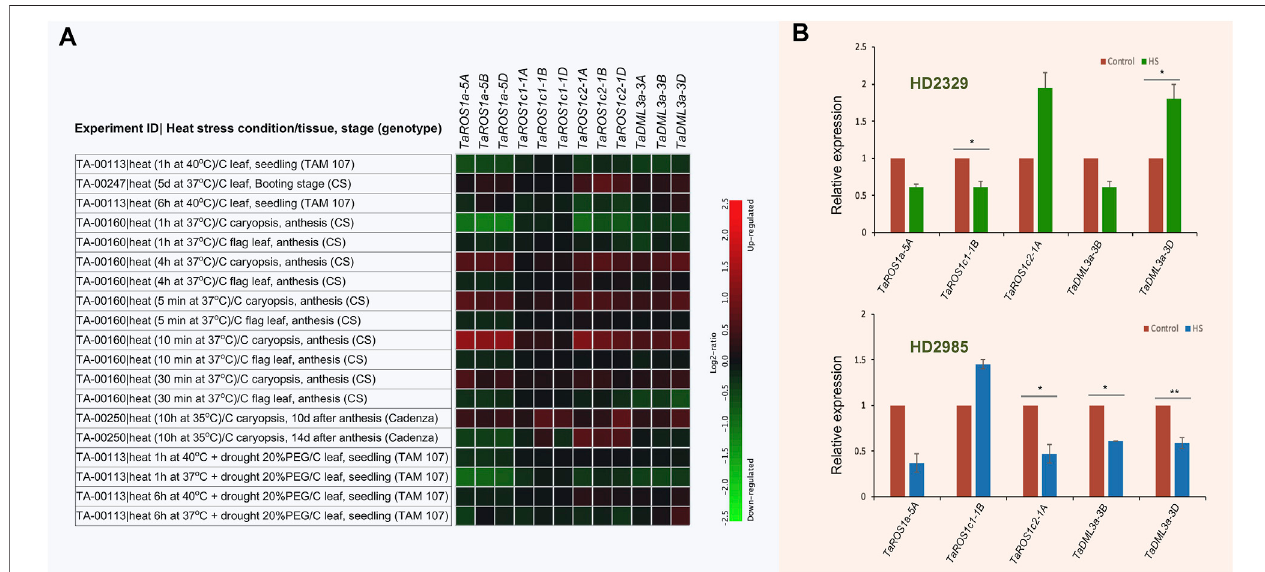
FIGURE7| Expressionpro fi lesofwheat dMTase genesunderheatstress(HS) conditions. (A) Heatmap showingtheexpression of12 TadMTase genesinvarious tissuesanddevelopmentalstagesduringheatstressconditions.The “ heatmap ” colorrepresents relativeexpression values,calculatedaslog2ratiosbetweenthesignal intensities from HS treated genotypes vs. controls (C). The red color indicates up-regulation and the green color indicates downregulation. (B) The relative expression levelof fi ve TadMTase ( TaROS1a-5A,TaROS1c1-1B,TaROS1c2-1A,TaDML3a-3B,TaDML3a-3D )geneswasanalyzedbyquantitativeRT-PCRinwheatseedling tissue under HS treatments (42 ° C for 2 h). Each bar value represent the means (±SE) derived from three biological. Asterisks on the bar showed signi fi cant differences between HS treated and control samples (* p < 0.05, ** p < 0.01, Student ’ s t -test). CS, Chinese spring; PEG, poly (ethylene glycol).